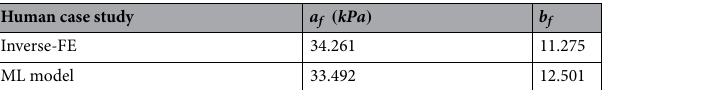
Table 5. ML model prediction of myocardial properties for the CMR-reconstructed human heart compared to the inverse FE model estimations.